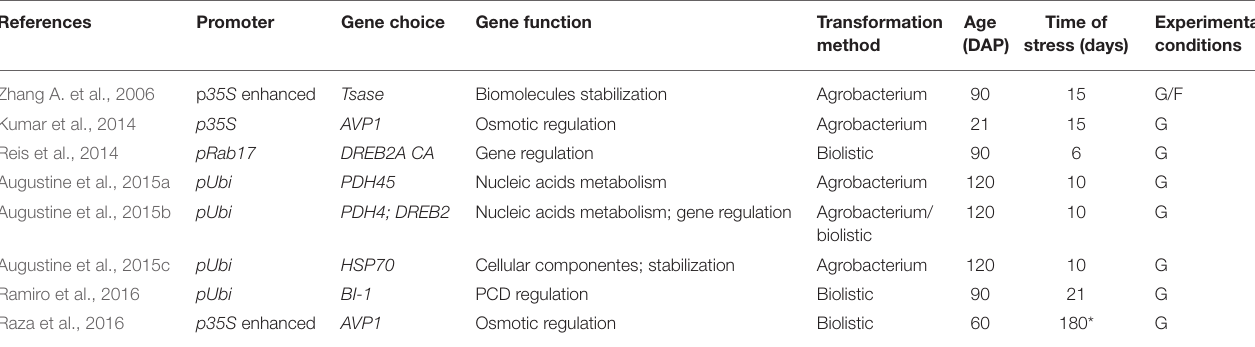
TABLE 4 | Sugarcane drought tolerance transgenic